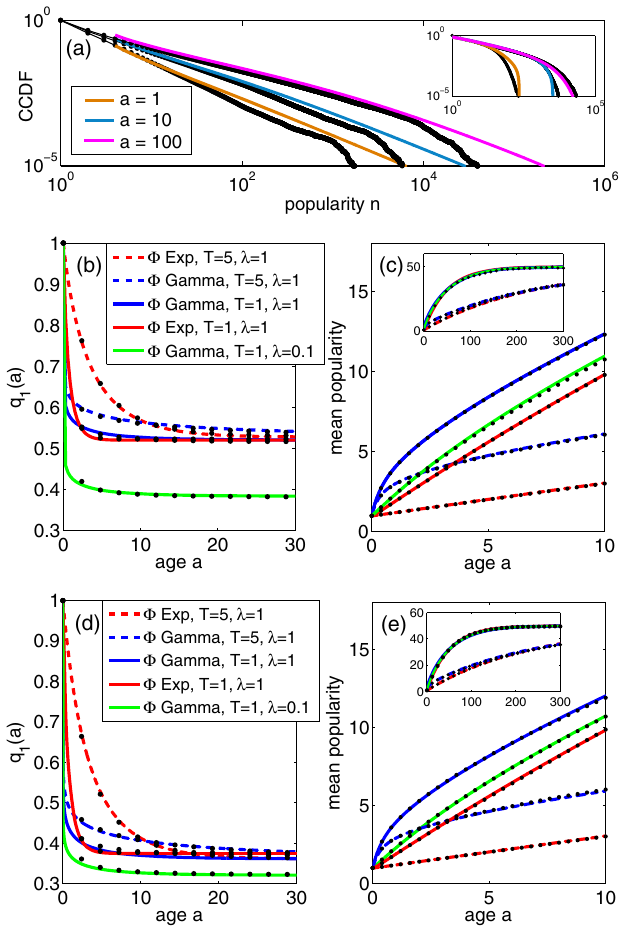
FIG. 4. Numerical simulations of the model, compared with analytical results. (a) Complementary cumulative distribution functions (CCDFs) for meme popularity at age a ; numerical simulation results (black) on a network with scale-free out-degree ∝ k − γ for k ≥ 4 with γ ¼ 2 . 5 ,meandegree z ¼ 11 distribution( p k